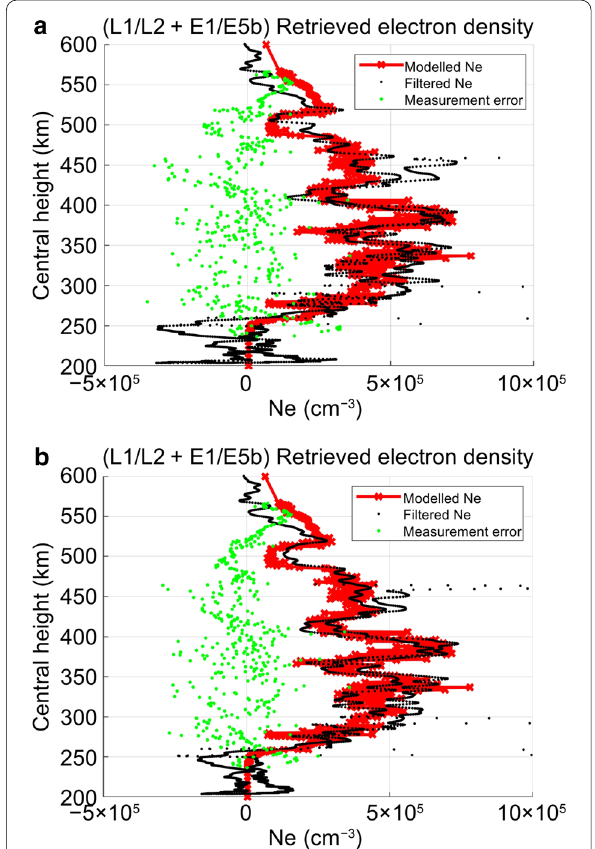
Fig. 13 Ne retrieval using GPS (L1 and L2) and Galileo (E1 and E5b) PRNs: a 13 July 2018 almanac b 8 March 2019 almanac. (Adapted from Peng and Scales